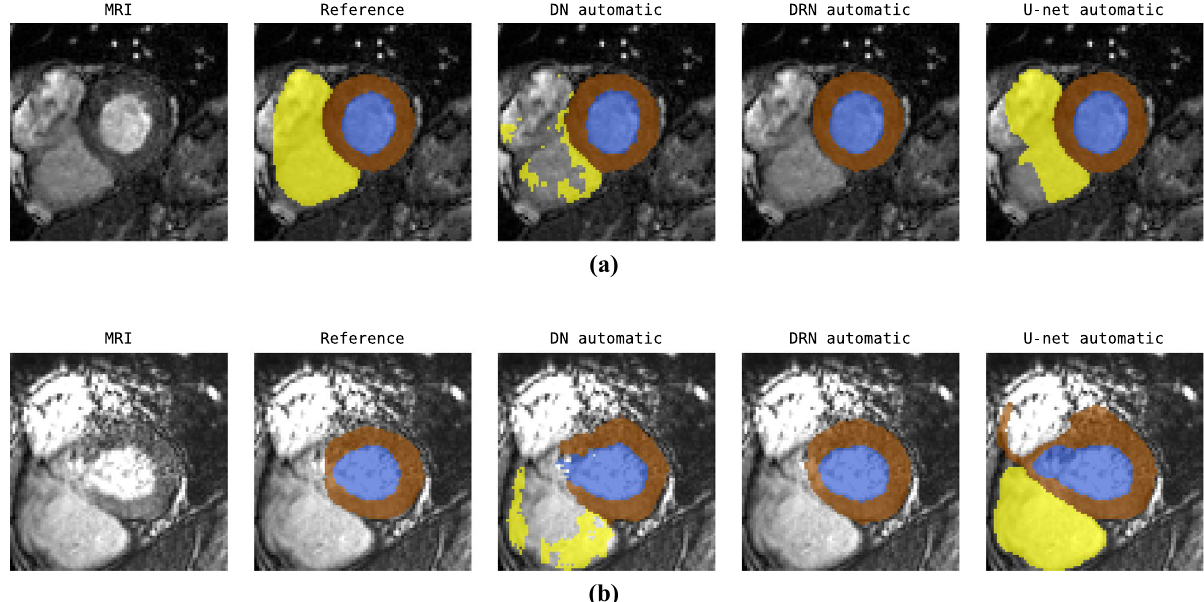
Figure 2. Examples of automatic segmentations generated by different segmentation models for two cardiac MRI scans (rows) at ES at the base of the Detection of slices with segmentation failures. To evaluate detection performance w.r.t. slices containing seg- mentation failures precision-recall curves for each combination of model architecture and loss function using e-maps (Fig. 3b, left) or b-maps (Fig. 3b, right) are shown. The results show that detection performance of slices containing segmentation failures is slightly better for all models when using e-maps. Furthermore, the detection network achieves highest performance using uncertainty maps obtained from the DN model and the lowest when exploiting e- or b-maps obtained from the DRN model. Table 3 shows the average precision of detected slices with segmentation failures per patient, as well as the average percentage of slices that do contain segmen- tation failures (reference for detection task). The results illustrate that these measures are positively correlated